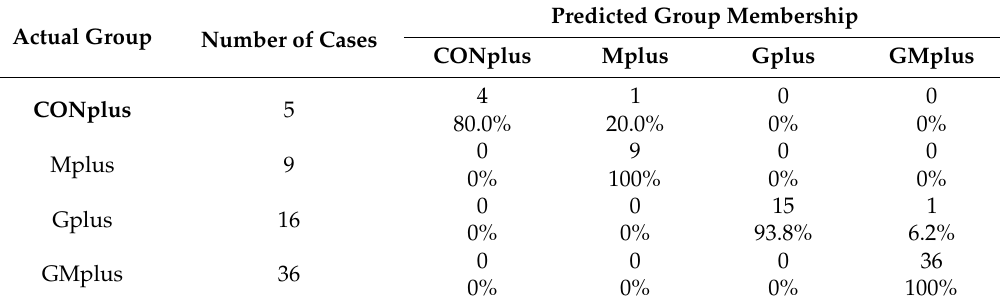
Table 8. Classification results of linear discriminant analysis (LDA) presenting percentage predicted group membership for actual